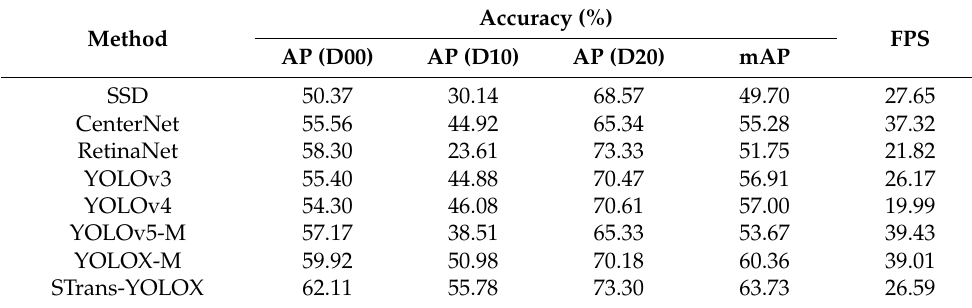
Table 2. Comparison results of different models on the pavement crack test set.